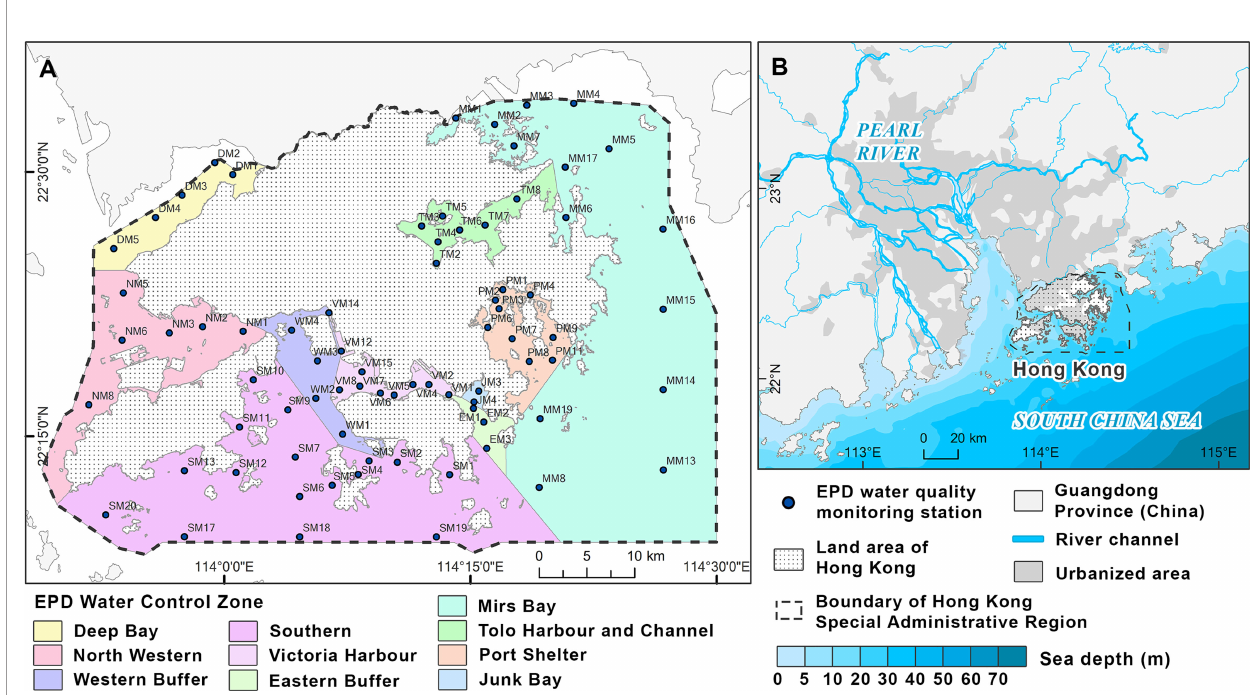
FIGURE 1 | (A) The study area of this study, including the 10 water control zones de fi ned by the Environmental Protection Department (EPD) of the Hong Kong government; (B) Location of Hong Kong in the regional